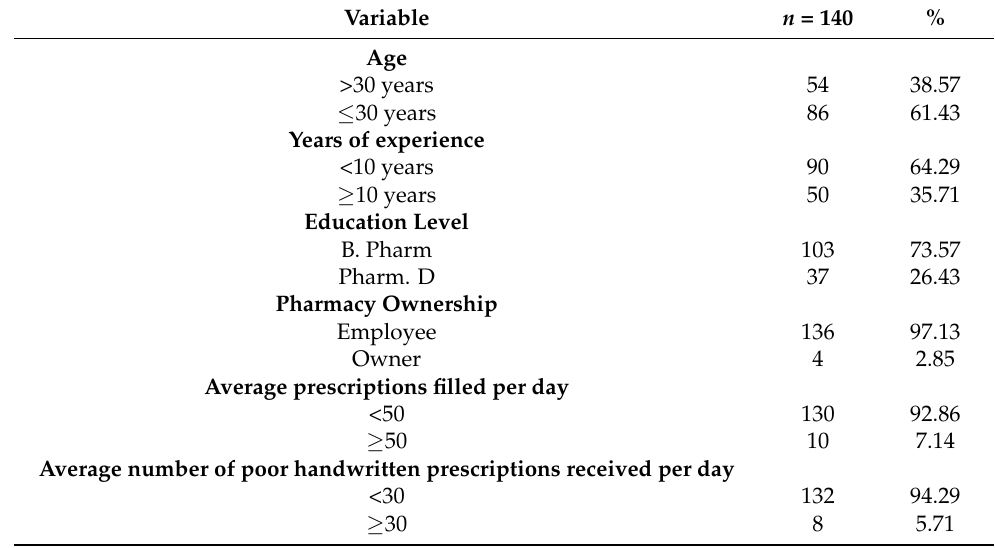
Table 1. Baseline data of the study subjects.